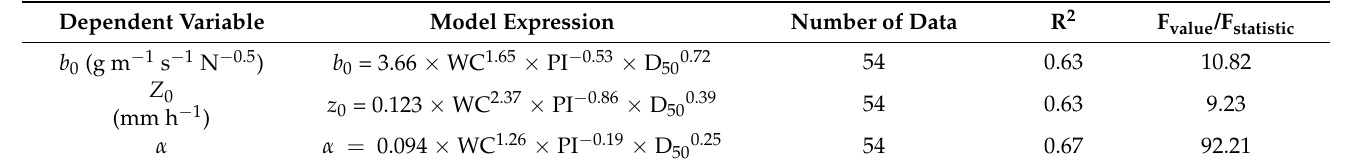
Table 3. Results of multiple nonlinear regression.